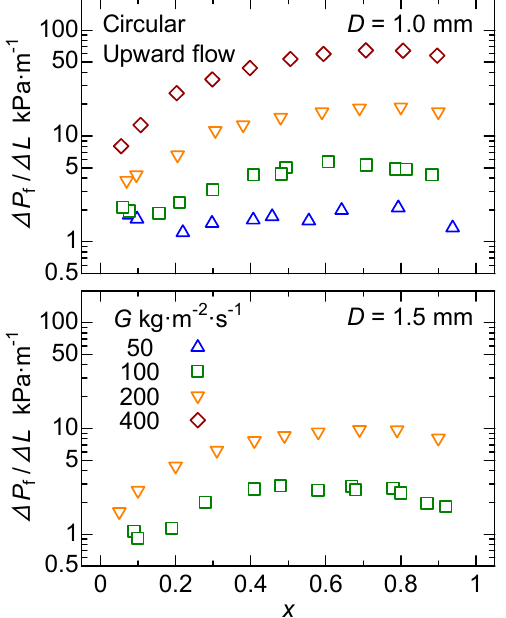
Figure 5. Frictional pressure drop vs. quality in upward flow. (Mass fluxes are parameters).